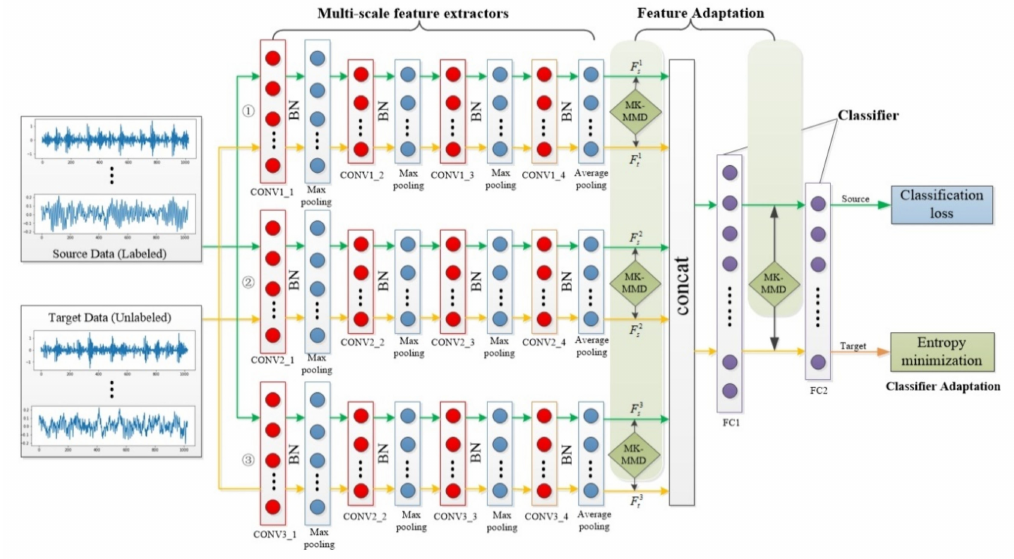
Figure 2. The architecture of the one-dimensional Multi-Scale Domain Adaptive Network (1D-MSDAN)